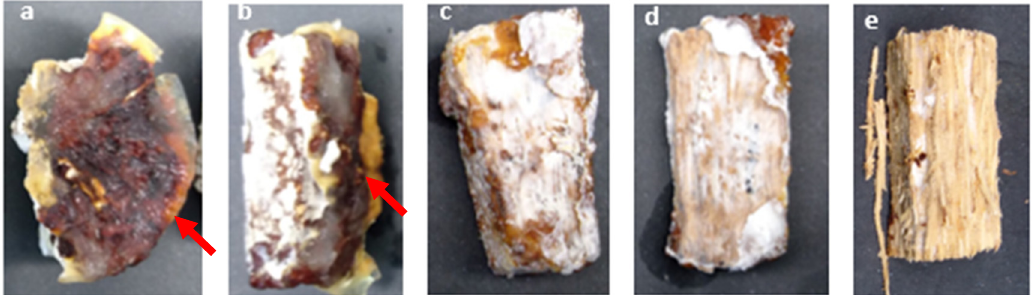
Figure 4. G. boninense inoculated woodblock after 120 days of inoculation ( a ). Untreated woodblock. Benzoic acid-treated woodblock with different concentrations: ( b ) 4.00 mM, ( c ) 4.50 mM, ( d ) 5.00 mM, and ( e ) 5.50 mM. Arrows indicate the basidiocarp formation on the woodblock.